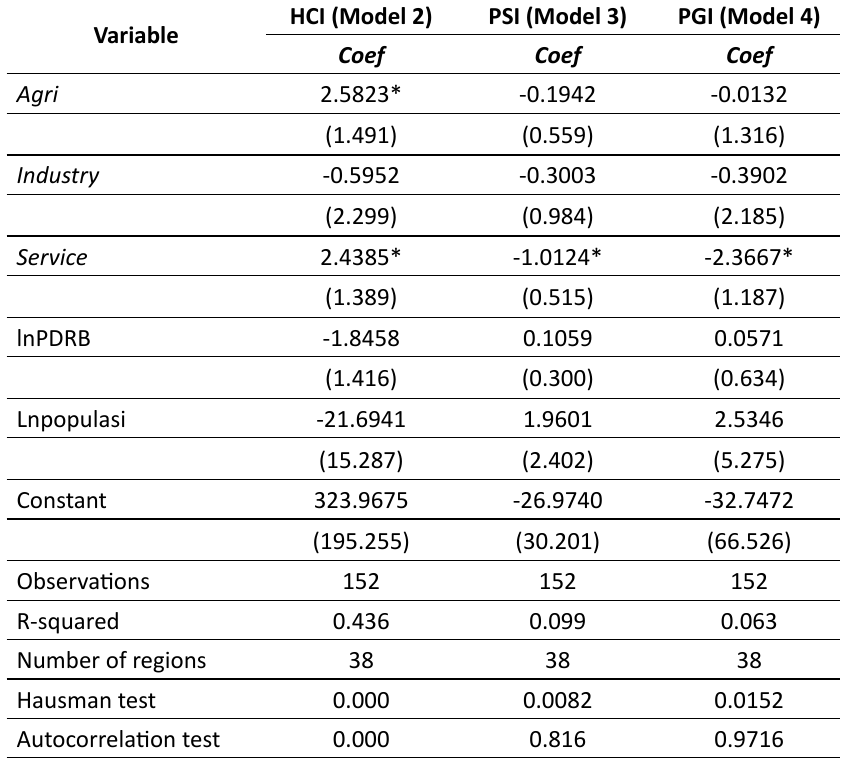
Table 2: Estimation